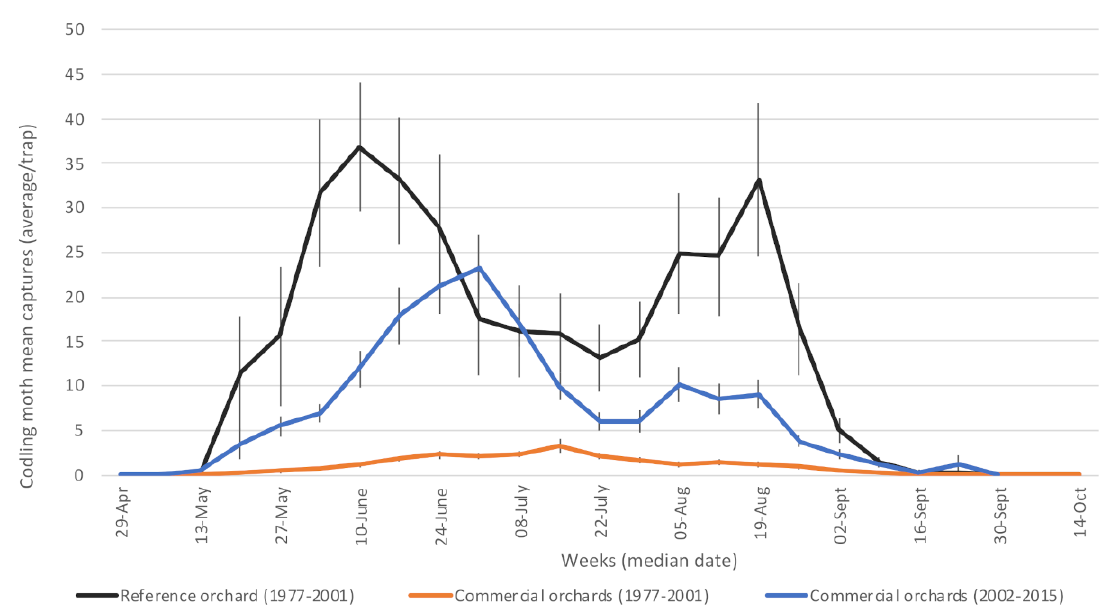
Figure 6. Average captures of codling moth adults in participating orchards. Reference (insecticide-free) orchard located at Frelighsburg, Qc (Agriculture and Agri-Food Canada, 1977–2001). Commercial orchards located at Franklin, Hemmingford, Oka, Rougemont and Saint-Paul-d’Abbotsford. Vertical bars represent standard